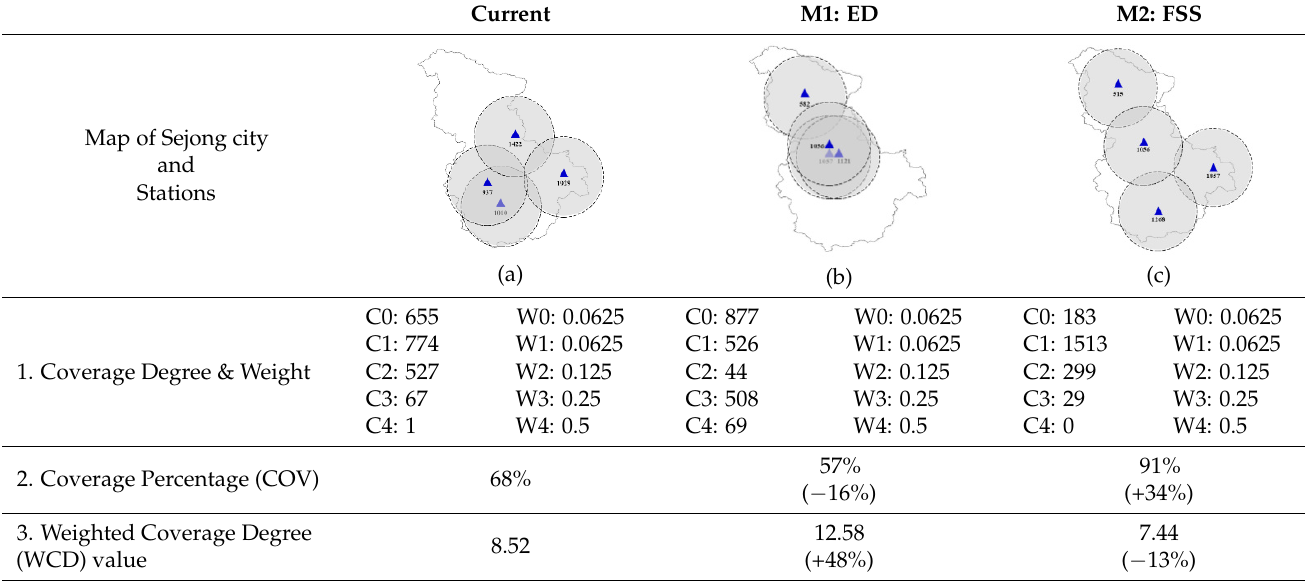
Table 3. The existing stations and the results of stations, coverage percentage, and weighted coverage degree of two methods: M1: ED and M2: FSS.